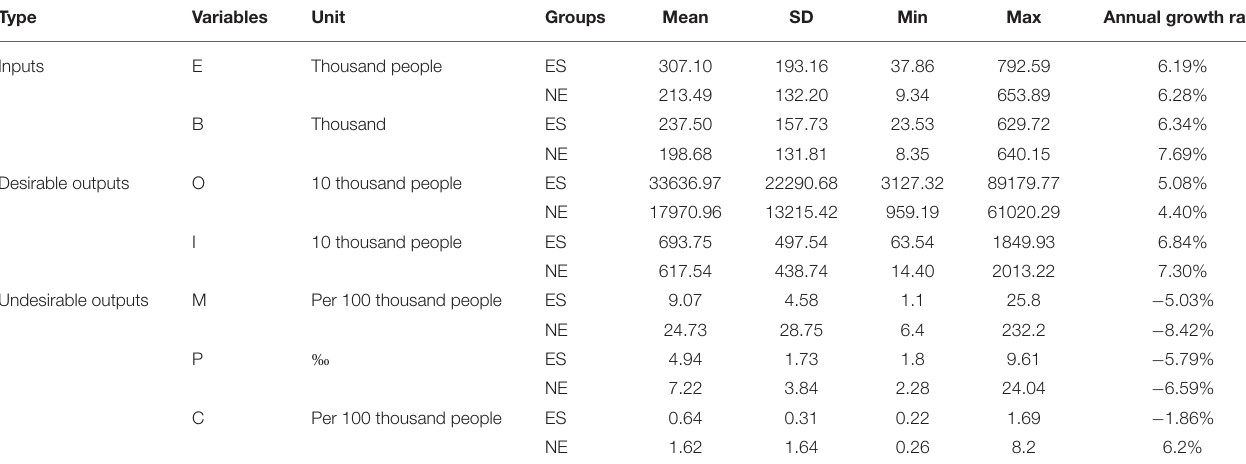
TABLE 1 | Descriptive statistics of input and output data (2009–2019).